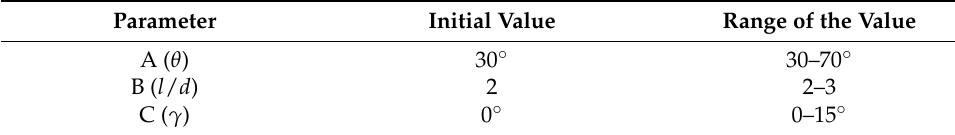
Table 3. Initial value and value range of key parameters.